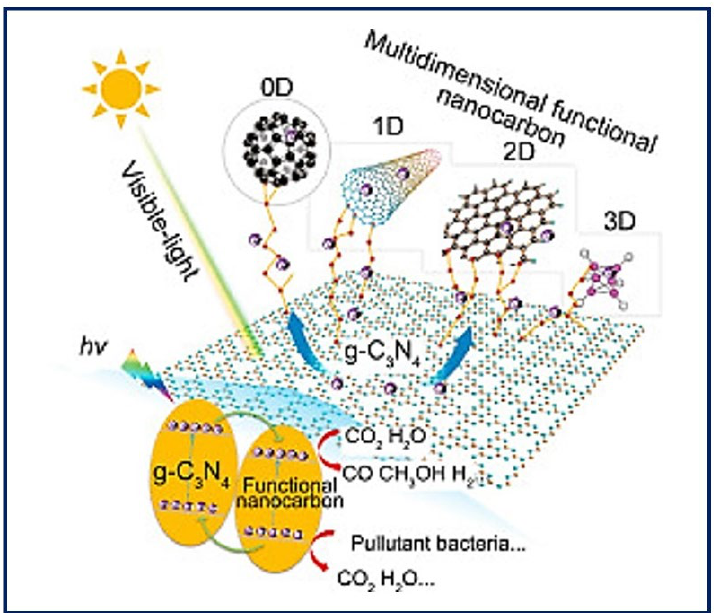
Figure 8. Utilization of multidimensional functional nanocarbon materials (0D–3D) as modifiers to enhance the visible light photocatalytic activity of g-C3N4. Bibliography consulted [82] is